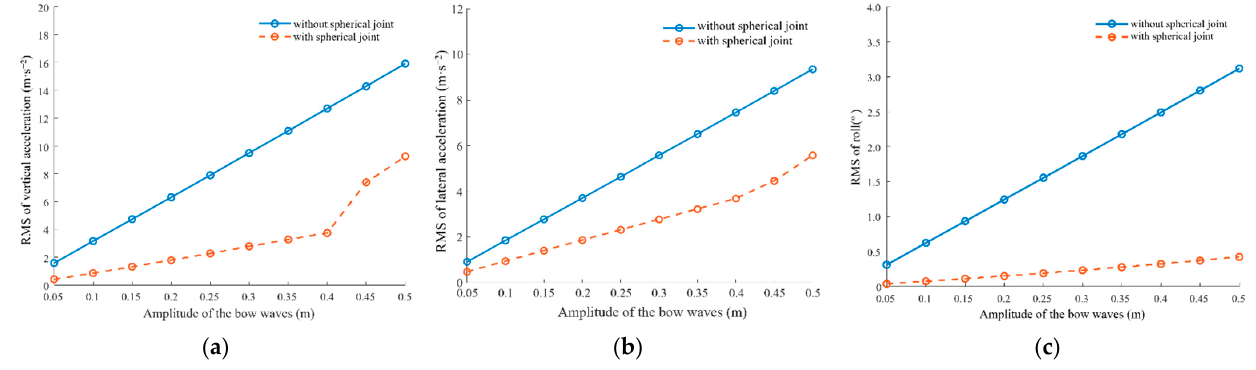
Figure 17. Seakeeping criteria values with and without spherical joint. ( a ) RMS of vertical acceleration; ( b ) RMS of lateral acceleration; ( c ) RMS of roll.